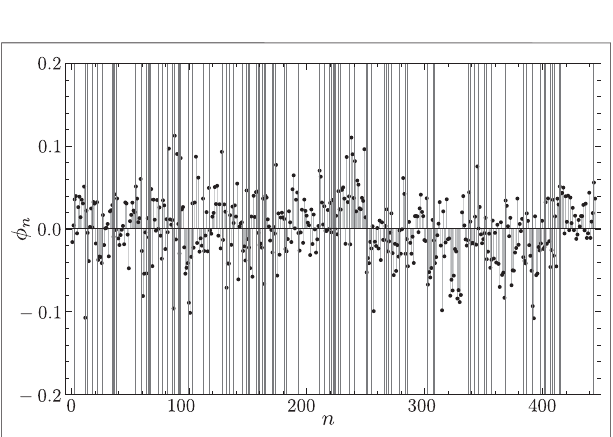
FIGURE 12 | Distribution of Helmholtz-Hodge potential for each asset. The abscissa represents n , while the ordinate represents Helmholtz-Hodge potential ϕ n . The thin vertical lines in this fi gure separate business sectors.